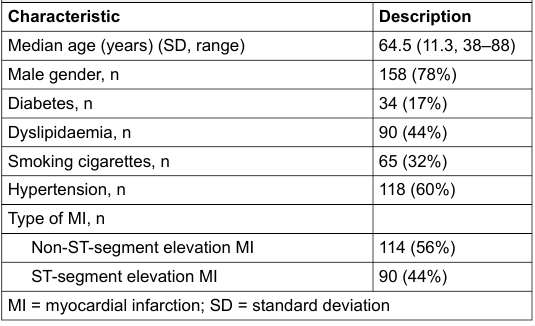
Table 1: Baseline characteristics of the study population (n = 204).